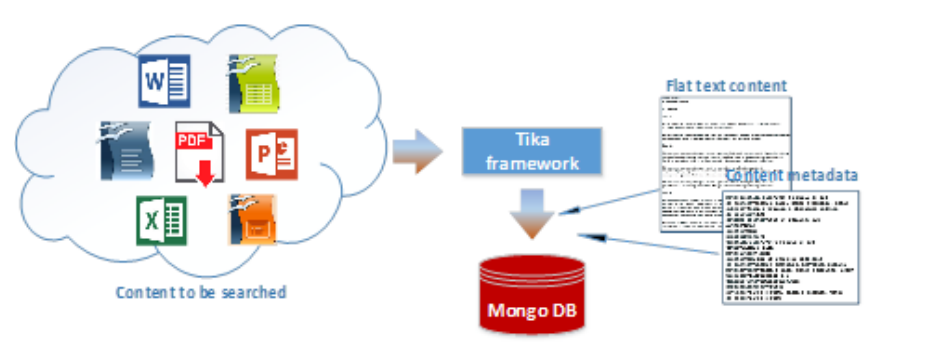
Figure 3 – Framework Backend 1st phase - 'Filtering'